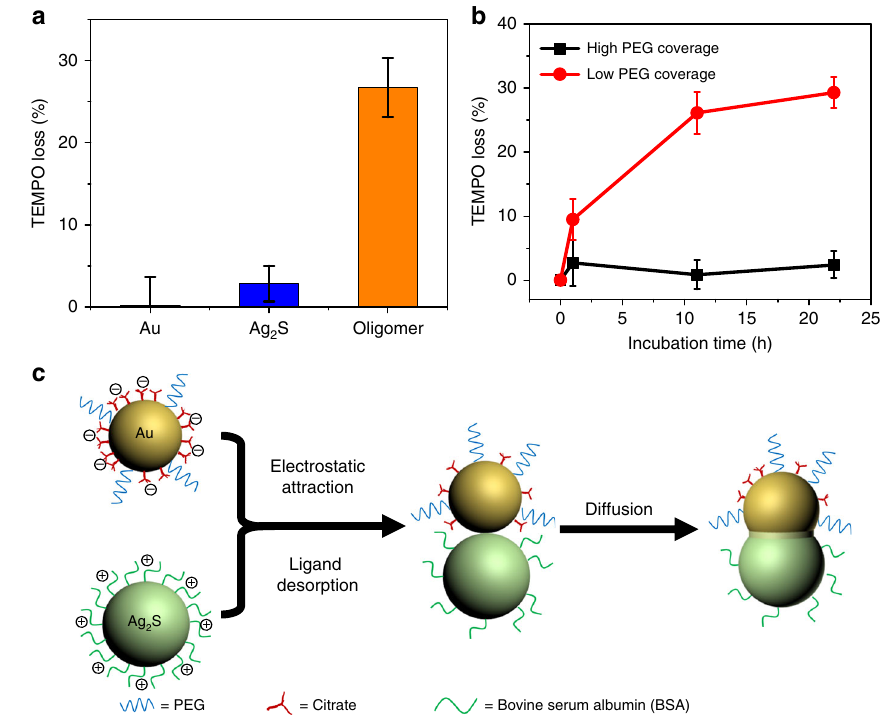
Fig. 2 Mechanism investigation of the welding process using ESR. a A comparison of TEMPO loss in the dispersion of Au NPs, Ag 2 S NPs, and Au – Ag 2 S HNPs, after the irradiation with visible light for 15 min. b TEMPO loss for incubated Ag 2 S and Au NPs with different polymer coverage as a function of incubation time. Each test is repeated three times. Standard deviations are represented by error bars. c Schematic illustration of the hypothesized